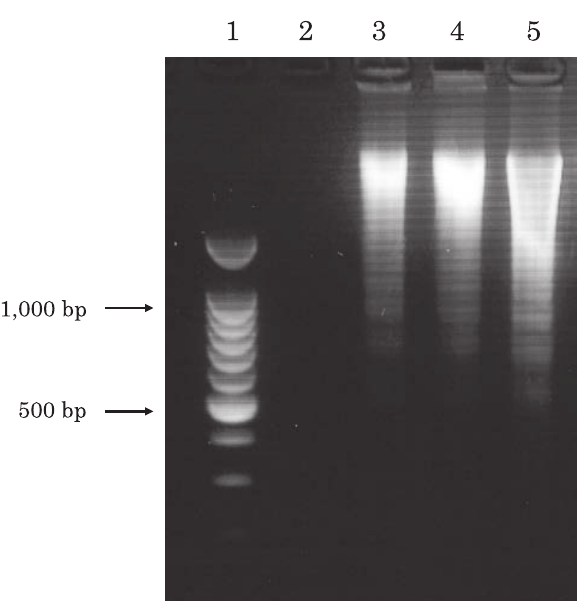
treatment with Andro, Ara-C or VCR. Lane 1; DNA size marker, Lane 2; untreated, Lane 3; Andro, Lane 4; Ara-C, Lane 5;